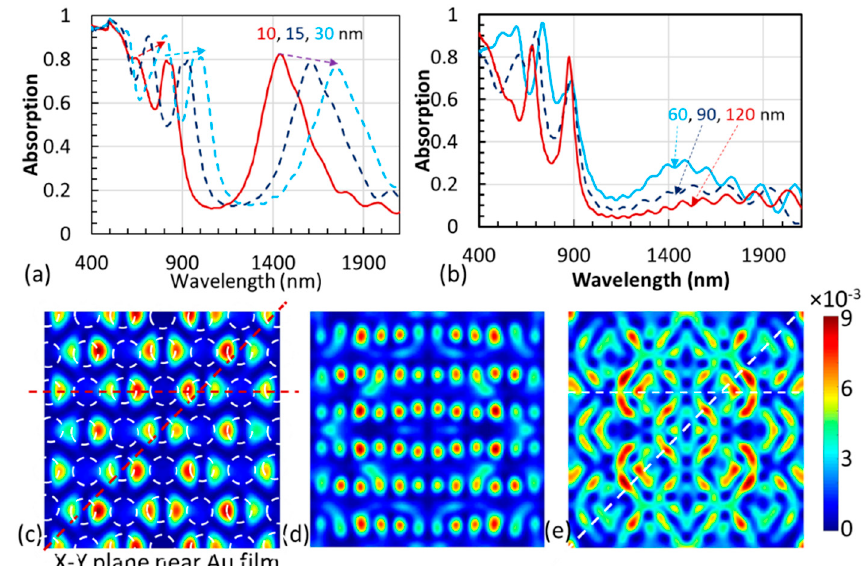
Figure 2. ( a ) Multiple-band absorption due to gap SPP in Au/SiO 2 /Au patterned with GPSC when the SiO 2 thickness is 10 (solid red line), 15 (dashed dark-blue line) and 30 nm (dashed light-blue line). ( b ) Absorption in Au/SiO 2 /Au patterned with GPSC when the SiO 2 thickness is 60 (solid light-blue line), 90 (dashed dark-blue line) and 120 nm (solid red line). E-field intensity in the X-Y plane inside the spacer ( c ) near the Au film, ( d ) in the middle of the spacer, and ( e ) inside the spacer near Au GPSC, in a stack of Au-GPSC/20-nm-SiO 2 /Au film. These E-field intensities are excited by a Gaussian source with a central wavelength of 1400 nm.